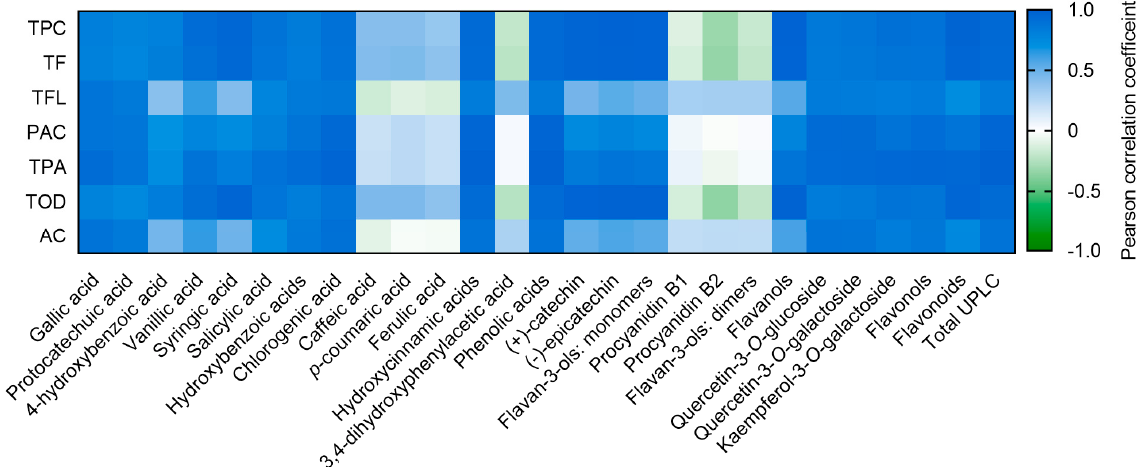
Figure 4. Heatmap depicting the Pearson correlation coefficients from the associations among in vitro determinations of phenolic families and the different phenolic compounds quantified using UPLC-ESI-MS/MS.